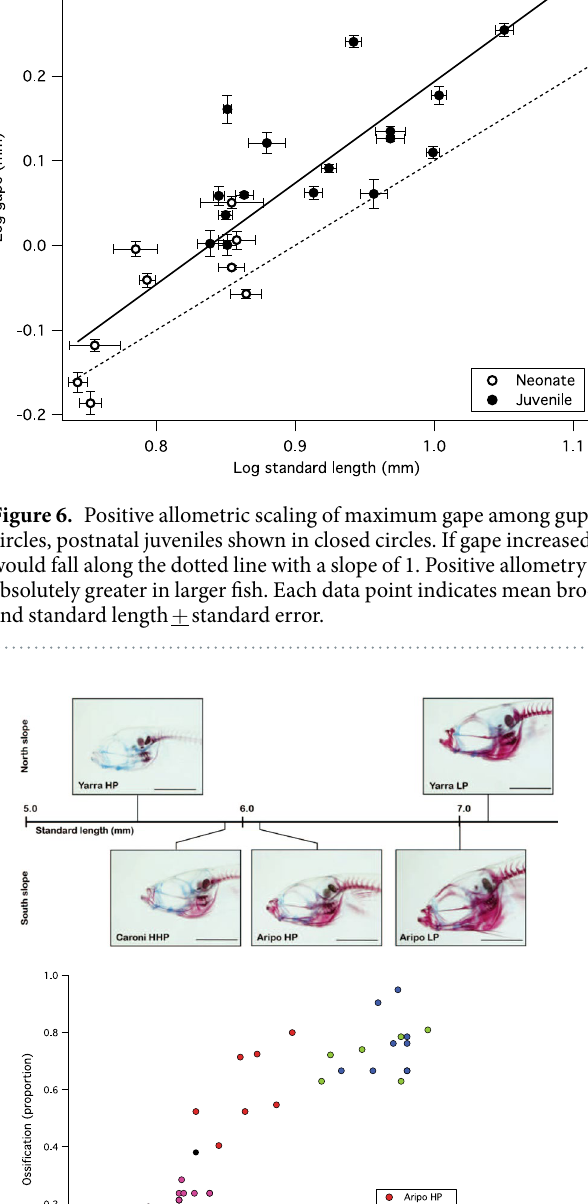
mobility might lead to the increase in scraping performance observed among larger offspring 19 .